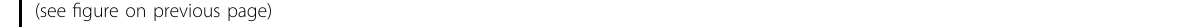
Fig. 2 PD-L1 facilitates angiogenesis in UM. a , b Stable silencing of PD-L1 in the UM cell lines MUM2B and MEL290 veri fi ed by western blot ( a ) and IF staining ( b ). c IGV tracks for PD-L1 expression from RNA-seq analysis of PD-L1-silenced cells and control cells. d Schematic diagram summarizing the angiogenesis assays used to determine the role of PD-L1, including HUVEC migration, HUVEC tube formation, CAM assays, and orthotopic xenografts. e HUVEC migration assay that investigates the effect of conditional medium from PD-L1-silenced cells and control cells on the migration ability of HUVECs. Scale bars, 100 µm. f Statistical analysis of the HUVEC migration assay. n = 3. Data are presented as means ± SD. Two-tailed unpaired Student ’ s t -test. g HUVEC tube formation assay that investigates the effect of conditional medium from PD-L1-silenced cells and control cells on HUVEC tubule formation. Scale bars, 50 µm. h Statistical analysis of the HUVEC tube formation assay. n = 3. Data are presented as means ± SD. Two-tailed unpaired Student ’ s t -test. i Representative images and quantitative analysis of blood vessels of CAM treated with conditional medium from PD-L1-silenced cells and control cells. n = 5. Data are presented as means ± SD. Two-tailed unpaired Student ’ s t -test. j Representative images of UM orthotopic xenografts generated by MUM2B cells expressing control or PD-L1 shRNA. k IF images of PD-L1 and CD31 in UM orthotopic xenografts. Scale bars, 40 µm. l Statistical analysis of CD31 expression in UM orthotopic xenografts. n = 5. Data are presented as means ± SD. Two- tailed unpaired Student ’ s t -test. m Representative bioluminescent images of UM orthotopic xenografts. n Statistical analysis of the bioluminescent signals in UM orthotopic xenografts. n = 5. Data are presented as means ± SD. Two-tailed unpaired Student ’ s t -test. o Representative images of H&E staining of UM orthotopic xenografts. p Statistical analysis of the tumor weight. n = 5. Data are presented as means ± SD. Two-tailed unpaired Student ’ s t